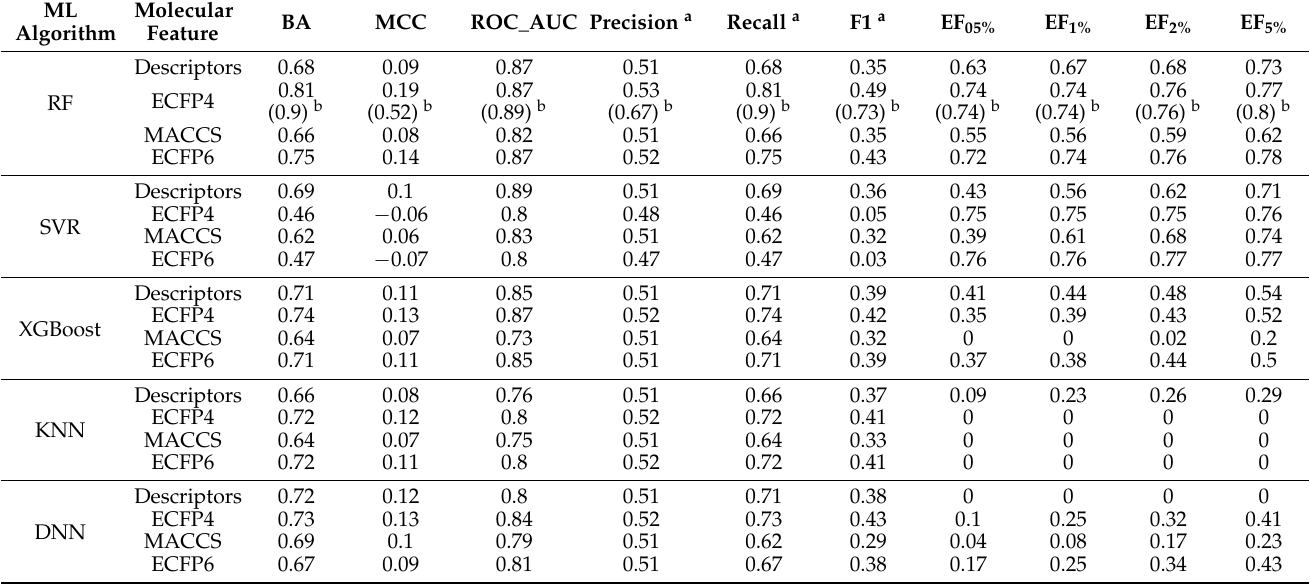
Table 4. The predictive performance parameters of the binary models on the decoy dataset. ML Molecular Algorithm Feature